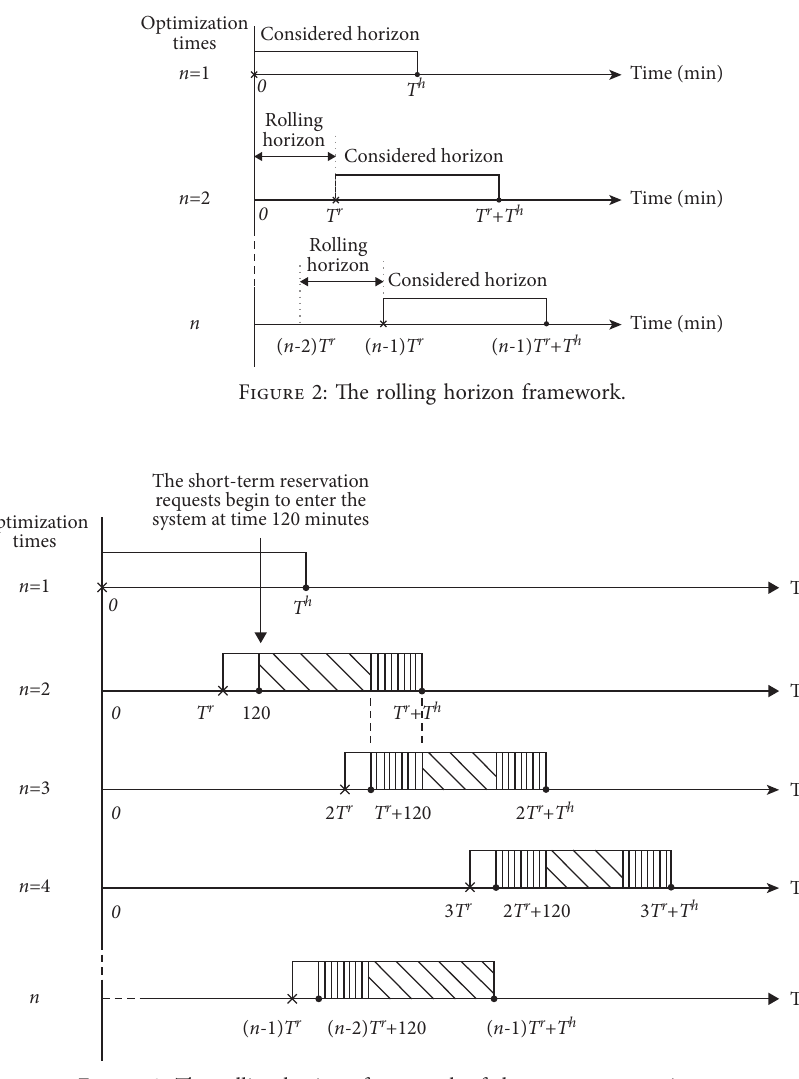
Figure 3: The rolling horizon framework of short-term reservation